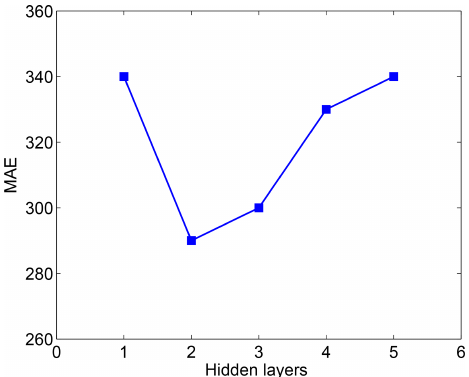
Figure 7. SFSDSA hidden layer number and MAE